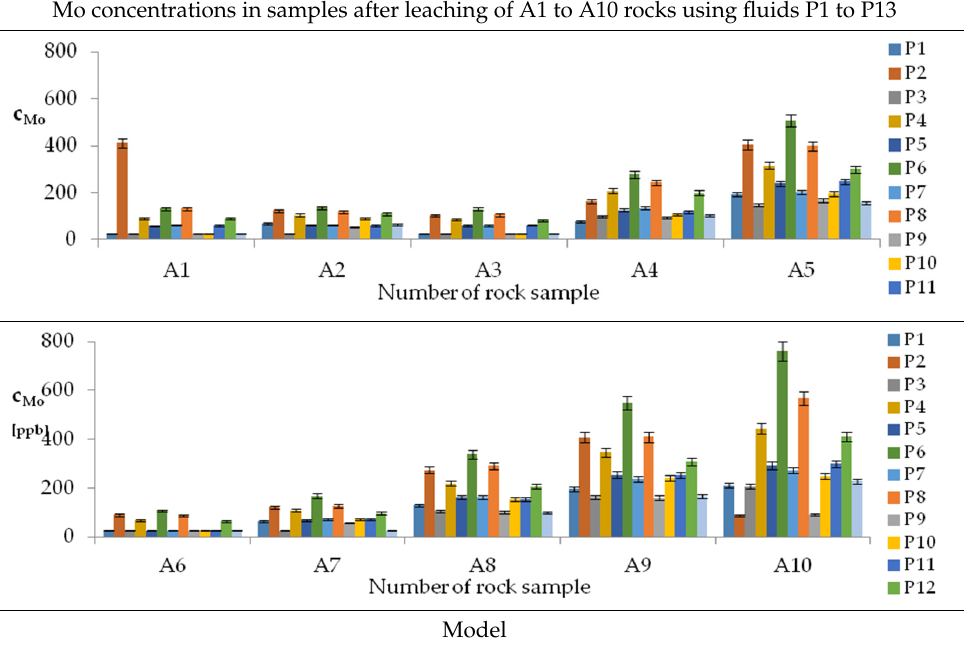
Table 8. Results of leaching samples A1 to A10 rocks using fluids P1 to P13 for Molybdenum (Mo). Mo concentrations in samples after leaching of A1 to A10 rocks using fluids P1 to P13